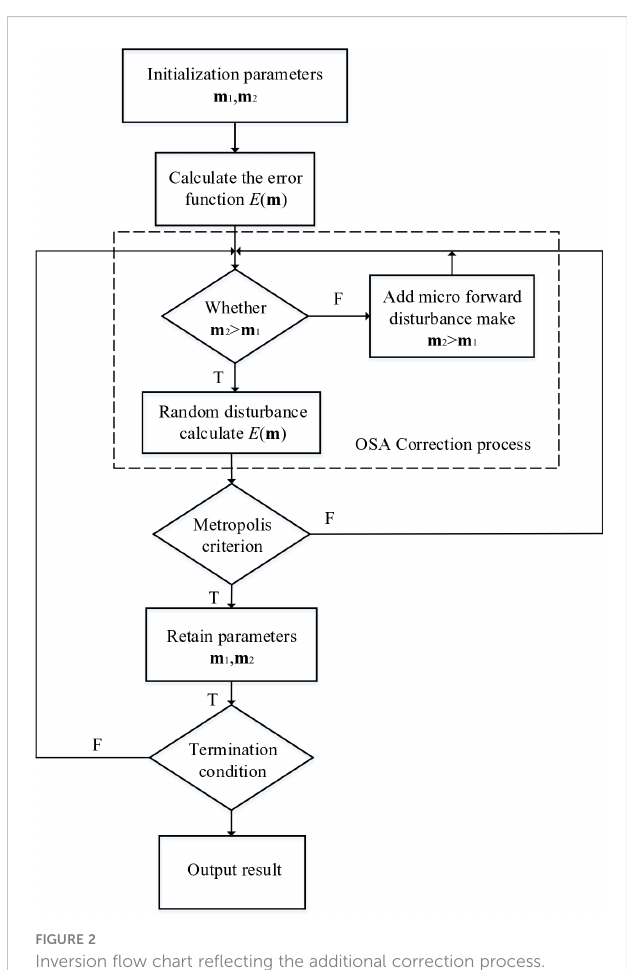
FIGURE 2 Inversion fl ow chart re fl ecting the additional correction